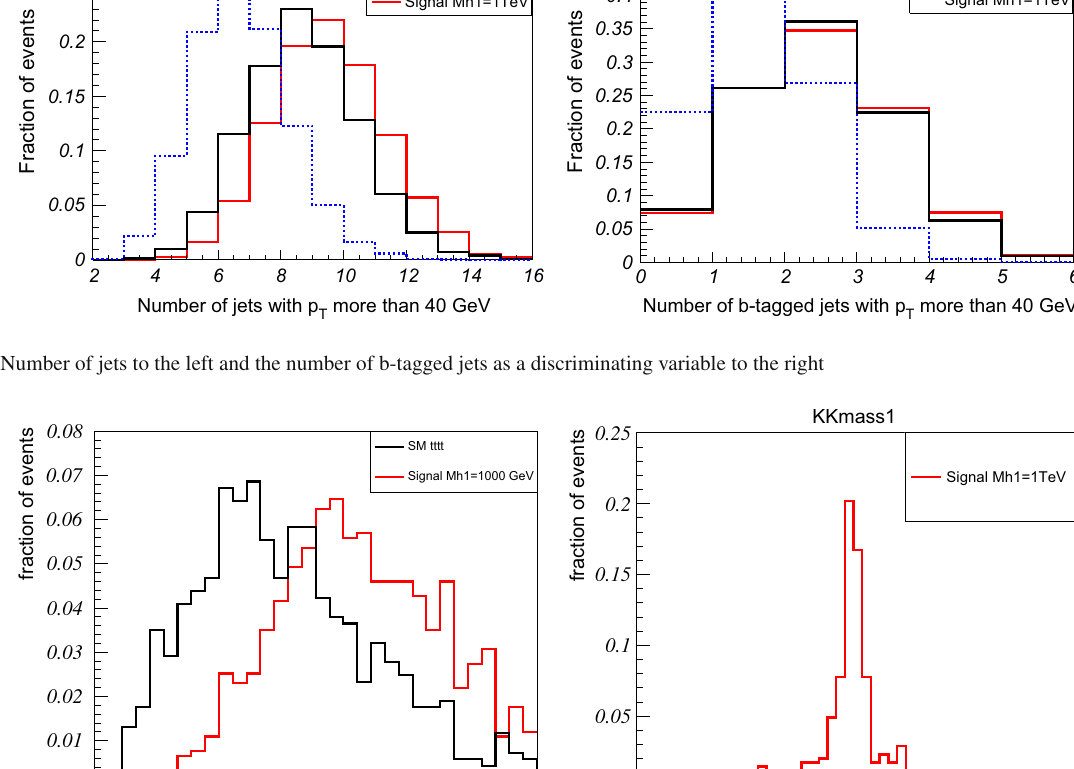
H scalar sum of p of all the jets T T